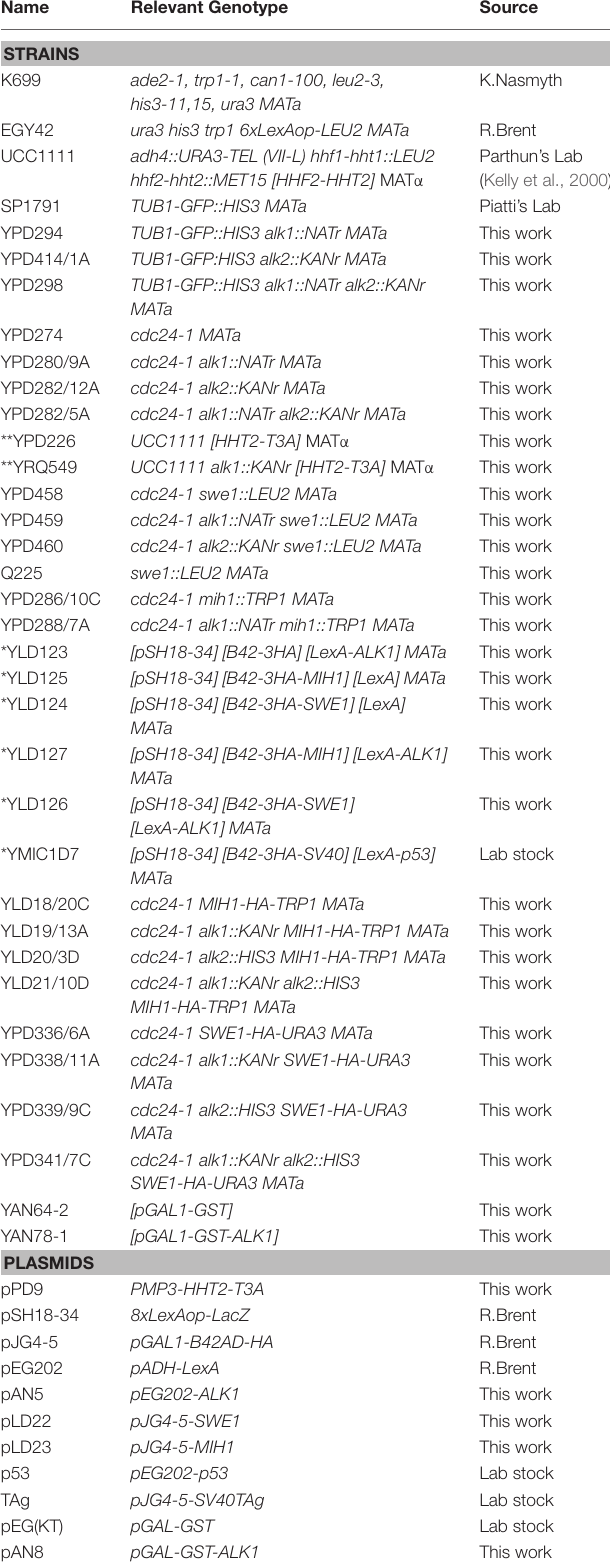
TABLE 1 | Strains and plasmids used in this